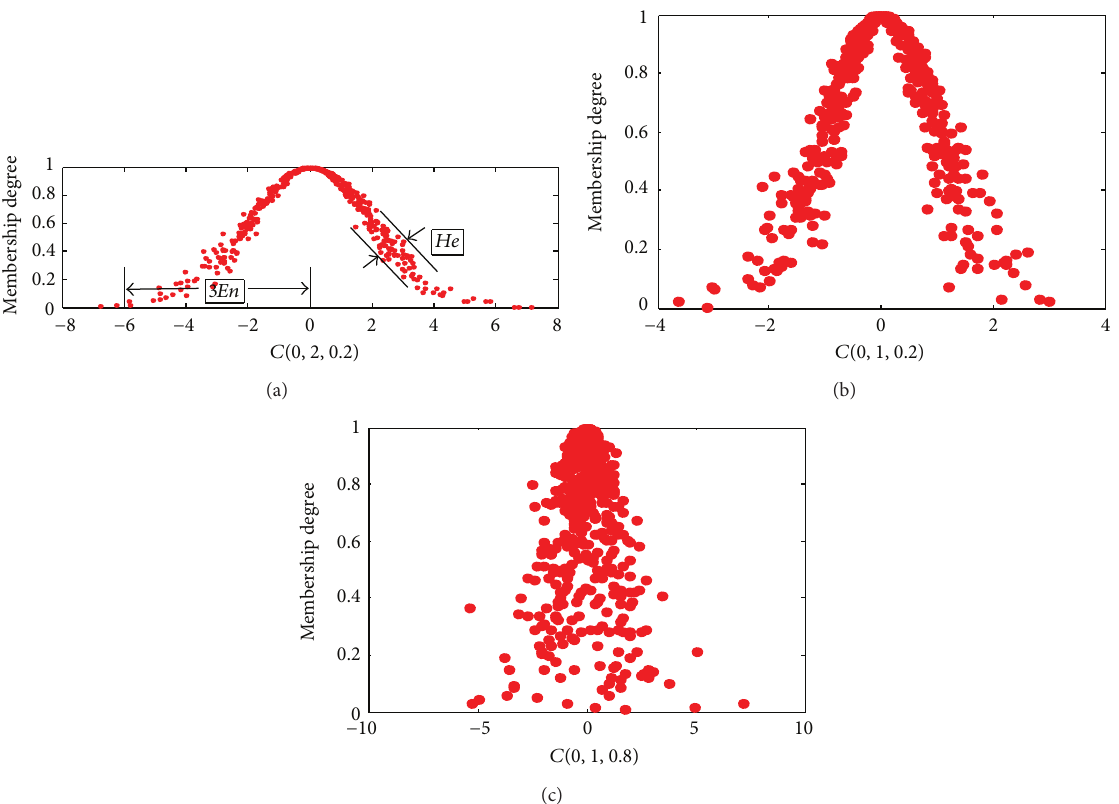
Figure 2: The cloud with different digital characteristics. 𝐶(0,2, 0.2) denote a cloud, 0 is expectation, 2 is entropy, and 0.2 is hyper entropy.